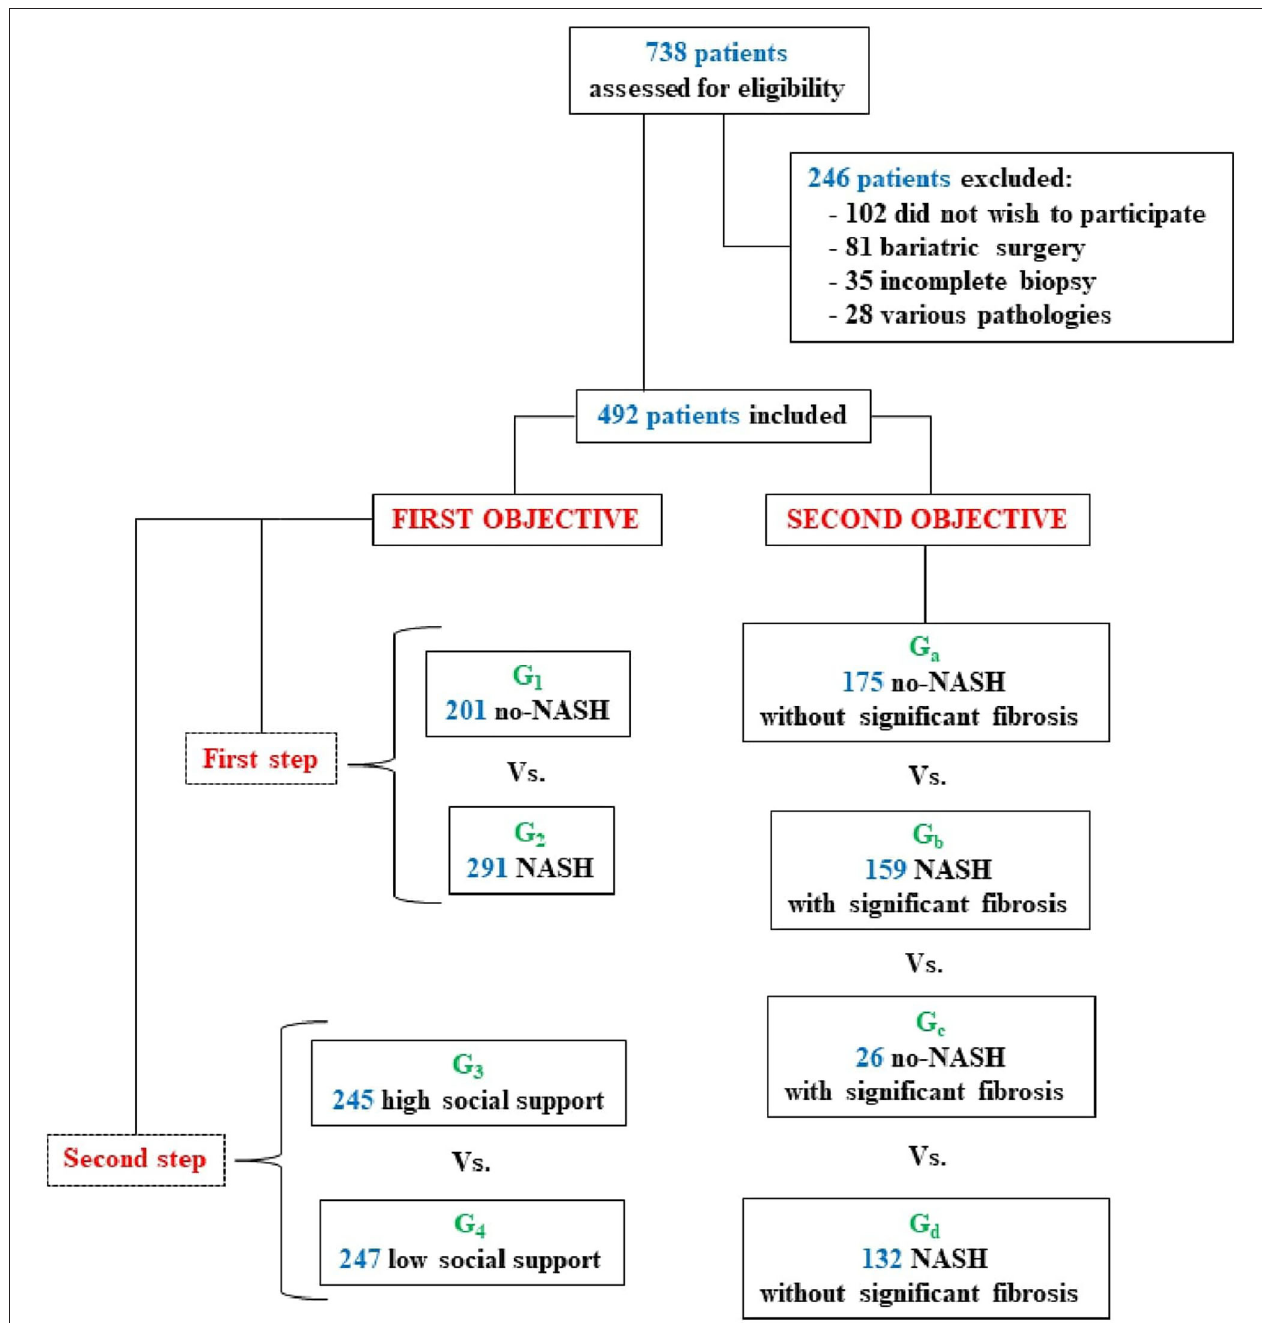
FIGURE 1 | Study participant selection